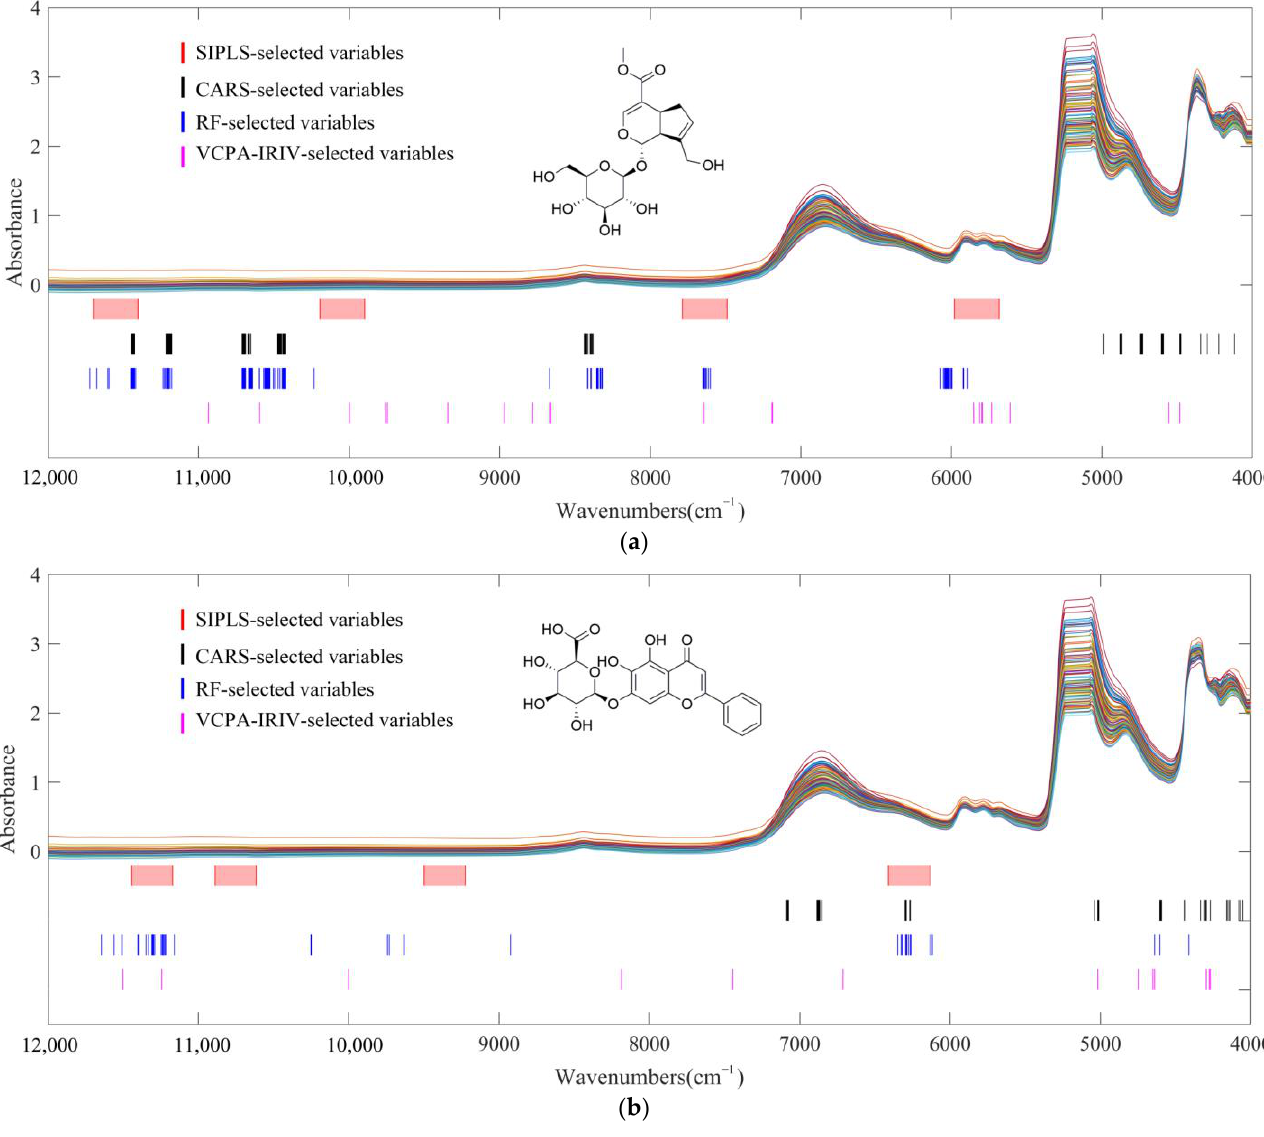
Figure 7. The optimal subset of variables selected by different variable selection methods. ( a ) gen- iposide; ( b )